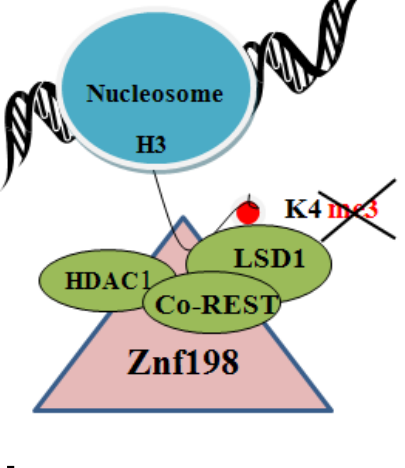
Figure 1. Diagram shows Znf198 interacting and stabilizing the LSD1-Co-REST-HDAC1 complex [58]. LSD1 removes the transcriptionally activating trimethylation of H3 on K4. HDAC1 removes the transcriptionally activating acetylation of